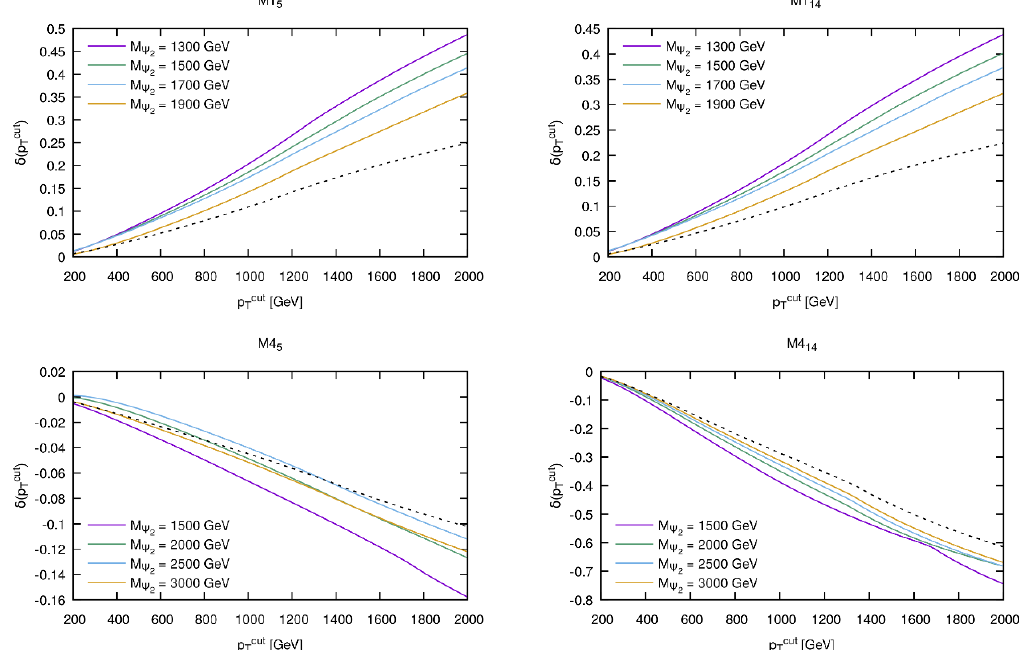
Figure 17 . The distribution (cid:14) ( p cut section